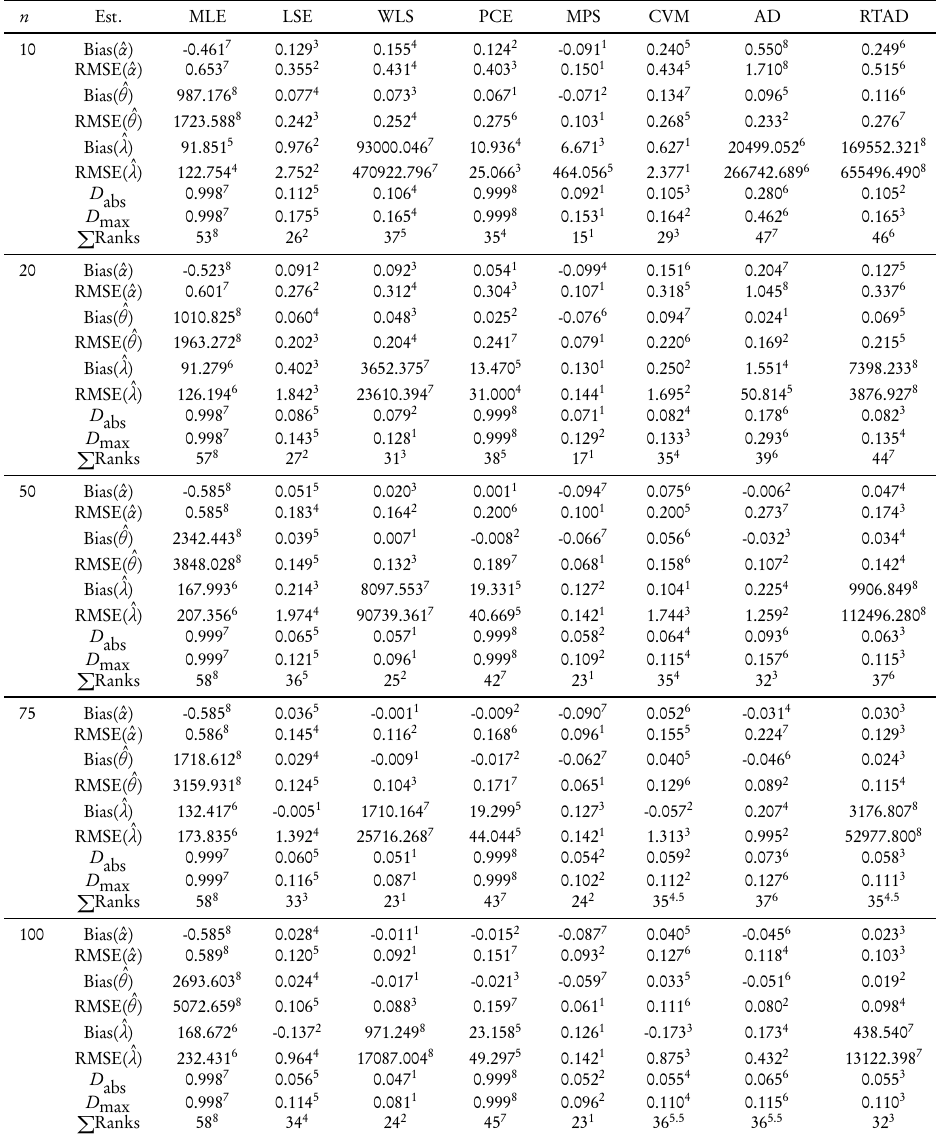
Simulation results for α = 0.5 , θ = 0.5 and λ = 0.5